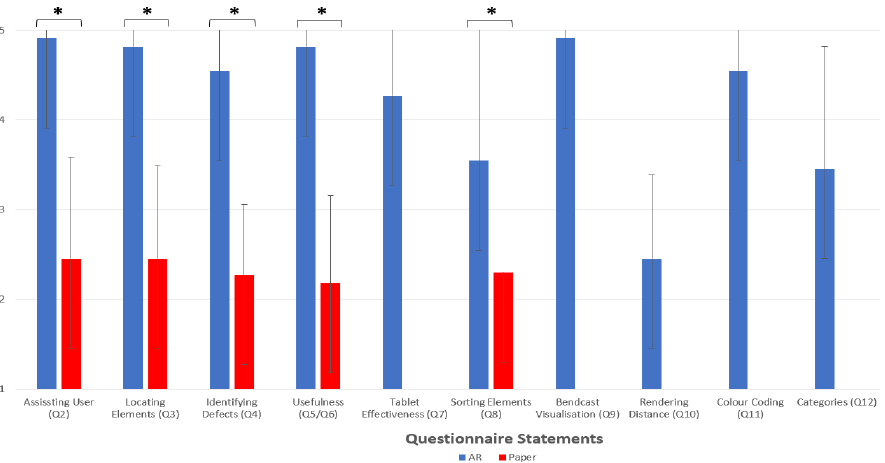
Figure 12. Questionnaire Results for each condition visualised in a bar chart with standard deviation (*: statistically significant).